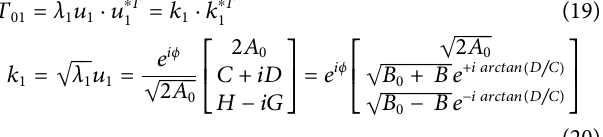
Here, ϕ ∈ [− π , π ] → absolutephase ofthe target, 2 A 0 → surface scattering; B 0 + B → double-bounce scattering; B 0 − B → volume scattering. Cloude decomposition model was used on the coherency matrix ( Eq. 4 ) to retrieve the scattering components. Figure 3 shows the color-coded RGB image of components retrieved from fully polarimetric multi-temporal and multifrequency datasets.